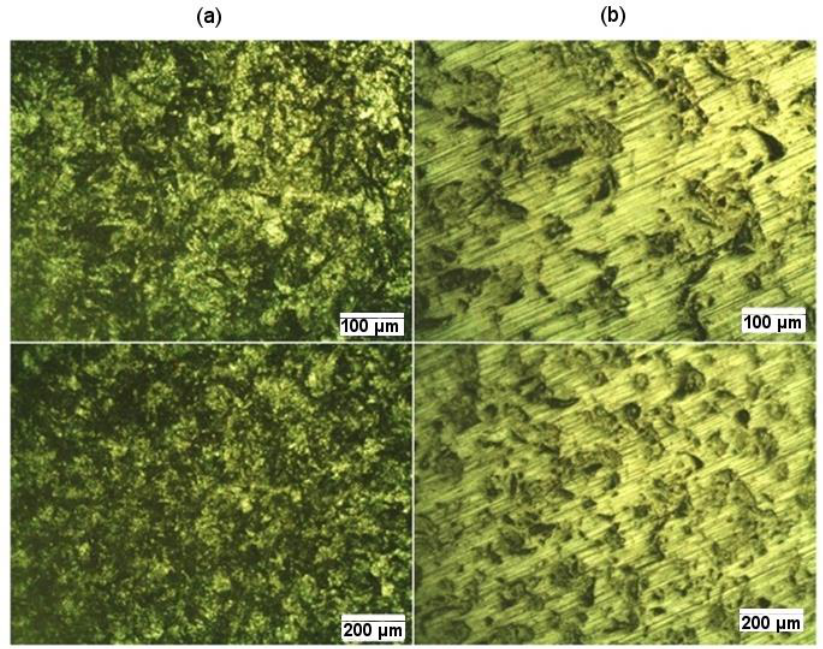
Figure 19. Surface images under optical microscope XJP-6A (Nanjing T-Bota Scietech Instruments & Equipment Co. Ltd., Nanjing, China): ( a ) before machining; ( b ) after machining in μ m.